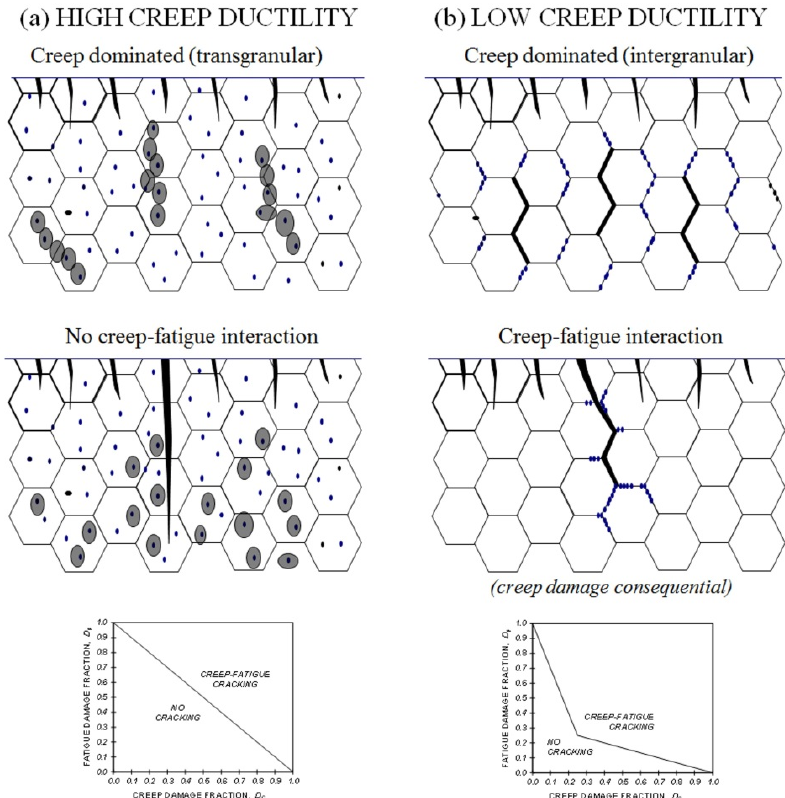
Figure 5. Influence of creep ‐ ductility on creep ‐ fatigue cracking mechanisms.